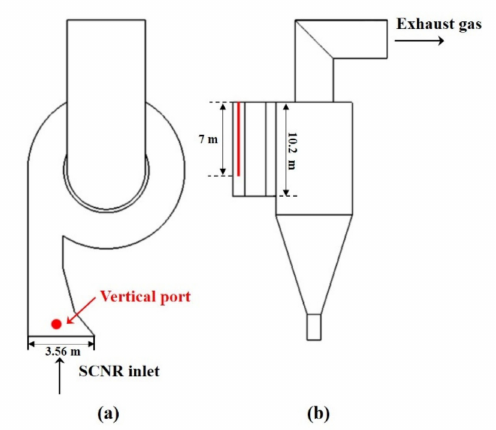
Figure 2. Positions of the vertical measurement ports of the three SNCR inlets: ( a ) top view; and ( b ) side view.